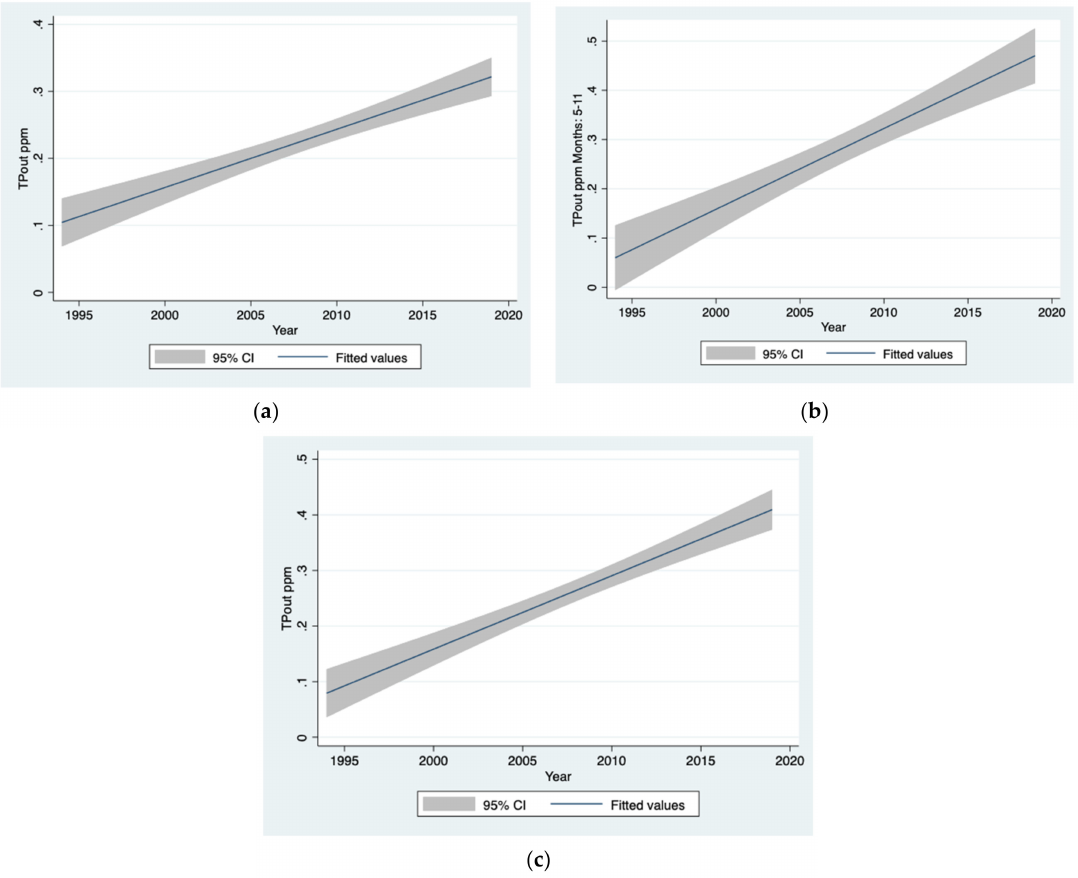
Figure 11. Linear regression (95% CI) between monthly means of TPout concentration (ppm) during crane months (12, 1, 2, 3, 4) ( a ) and no-crane months (5–11) ( b ) in 1994–2018. Linear regression (95% CI) between annual means of TPout concentrations (ppm) in (1994–2018) ( c ).